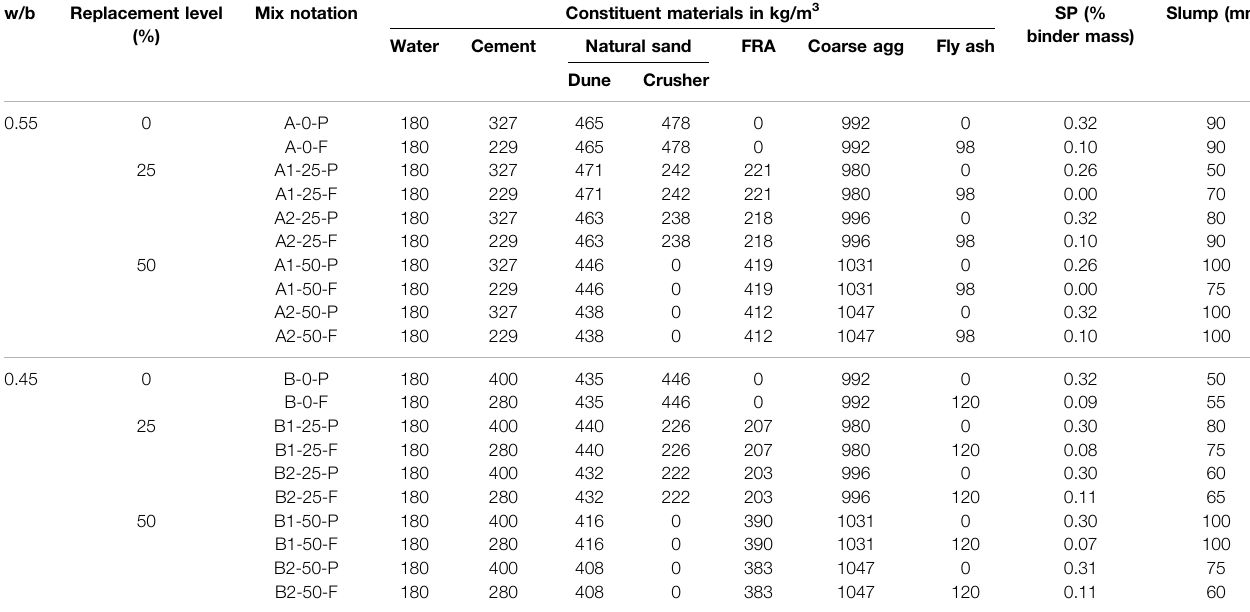
TABLE 5 | Composition of concrete mixtures. w/b Replacement level